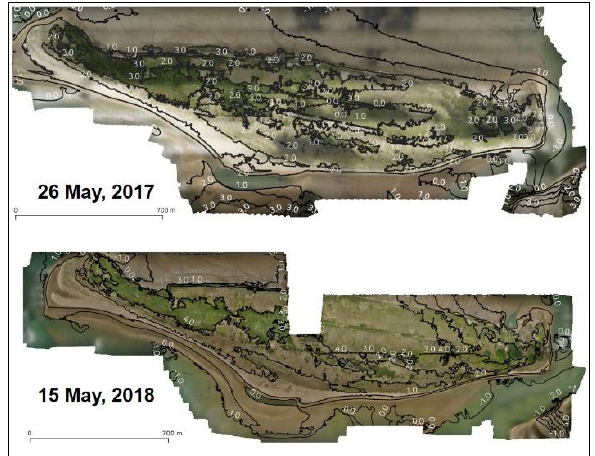
Figure 5. Contour maps of Jinu-do Three orthophotos obtained through UAV aerial photographs show that the shoreline in the downward direction (toward open sea) is changed drastically (Figure 4). In particular, the vegetation of May 2018 was found to increase slightly more than May 2017. When the contour lines 2017 and 2018 are compared from -1 m to 3 m, the topographic change is more evident near the coastline and focused on intertidal zone (Figure